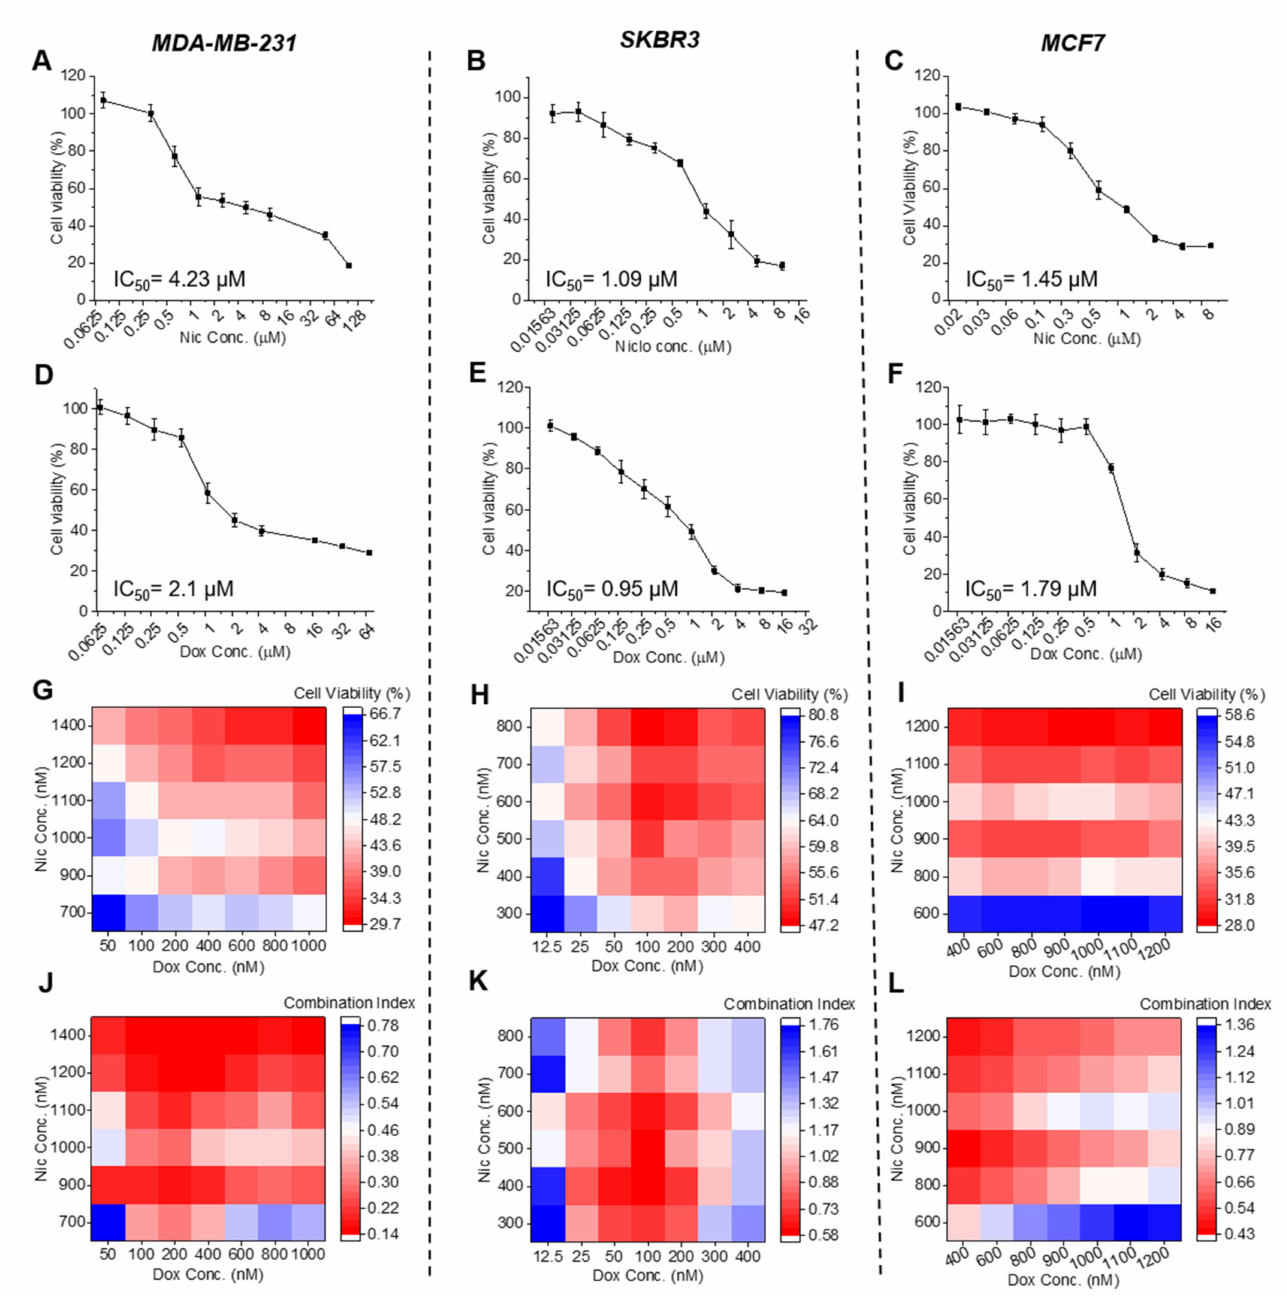
Figure 1. Effect of individual and sequential treatment of niclosamide (Nic) and doxorubicin (Dox) on breast cancer cells. In vitro cytotoxicity of individual ( A – C ) Nic and ( D – F ) Dox on cells of all three subtypes of breast cancer at different doses for 24 h ( n = 3). Cell viability heat maps of combination therapy (24 h of Nic treatment followed by 24 h of Dox treatment) in ( G ) MDA-MB-231, ( H ) SKBR3, and ( I ) MCF7 cells. Combination index heat maps in ( J ) MDA-MB-231, ( K ) SKBR3, and ( L ) MCF7